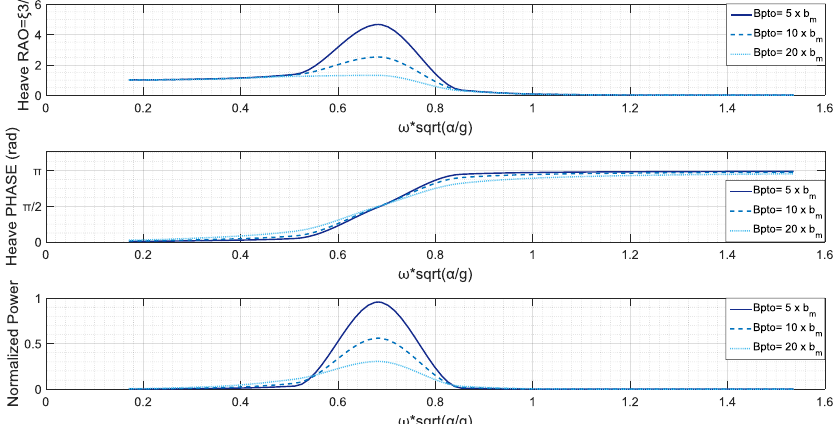
Figure 7. Heave Response amplitude operator (RAO) RAO, Phase RAO and Normalized Power Output for Cylindrical WEC with a / h = 1/3.5 and d / a =